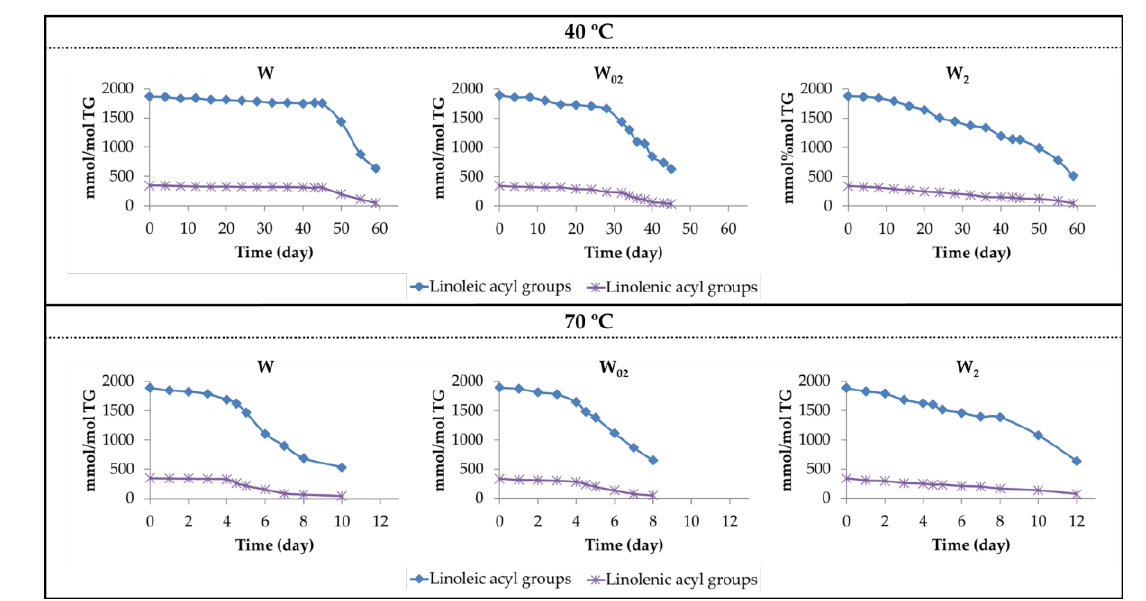
Figure 2. Evolution of the concentration, expressed as mmol/mol TG, of linoleic and linolenic acyl groups in walnut oil with different enrichment levels of αT (W, W 02 , and W 2 ), subjected either to 40 °C or to 70 °C up to advanced stages of the oxidation process.